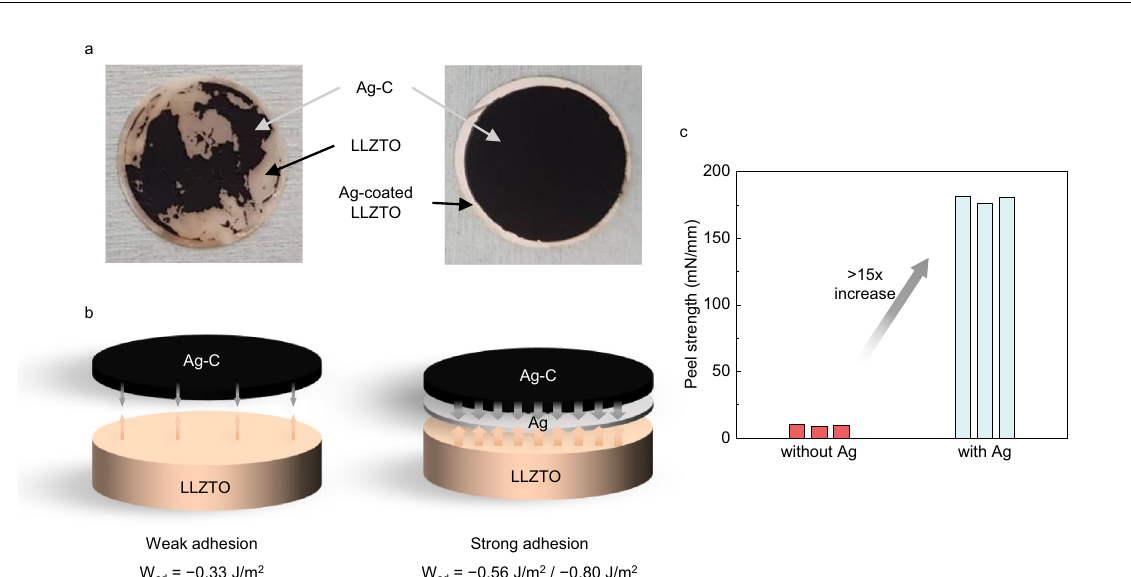
Fig. 3 | Improvements of adhesion between LLZTO and Ag-C interlayer by introducing Agcoating layer.a OpticalimageofLLZTO afterthetransferofAg-C interlayer (left) without and (right) with Ag coating layer. b Schematic models of LLZTO/interlayer interface (left) without and (right) with Ag layer, illustrating the